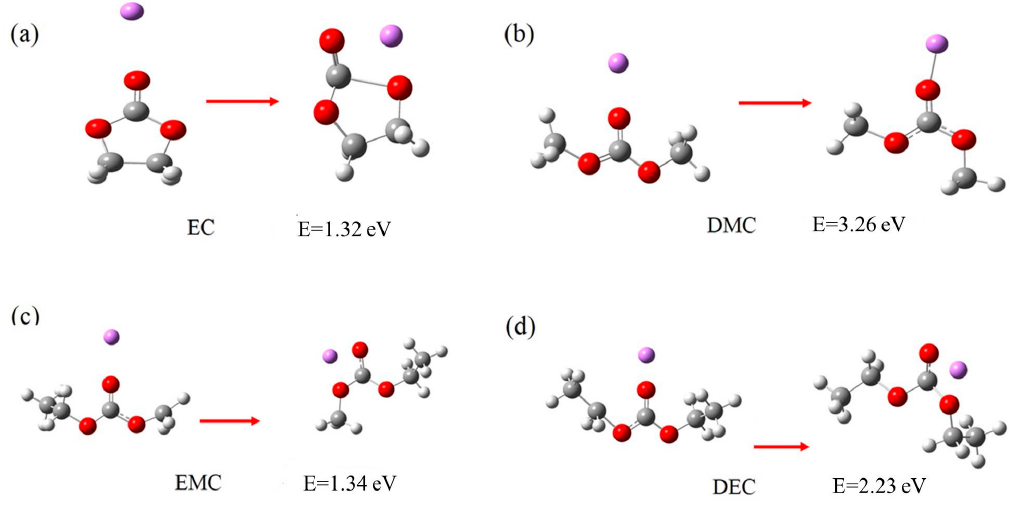
Figure 10. Optimized geometries of the neutral and reduced Li + -solvent complexes from B3LYP QC calculations. The binding energy of Li + with ( a ) ethylene carbonate (EC), ( b ) dimethyl carbonate (DMC), ( c ) ethyl methyl carbonate (EMC), and ( d ) Diethyl carbonate (DEC) are given vs. Li/Li + .